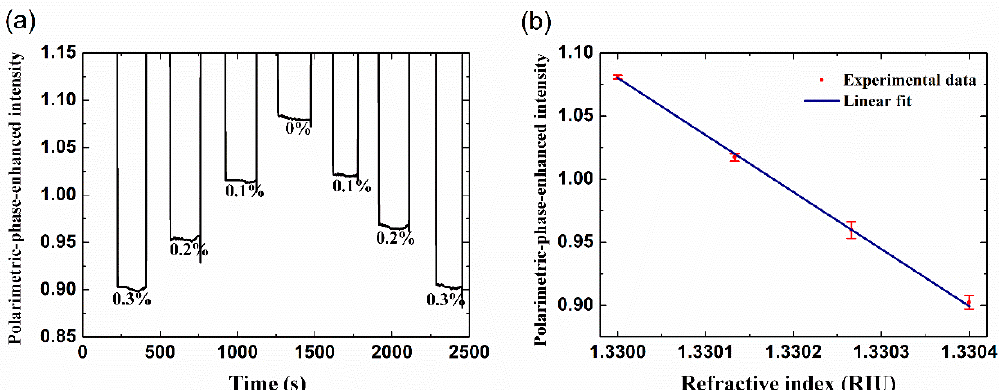
Figure 6. ( a ) Real-time record of the subtracted, phase-induced intensity I PA with different solutions; ( b ) the linear fit between the measured I PA and the refractive index of the solution.